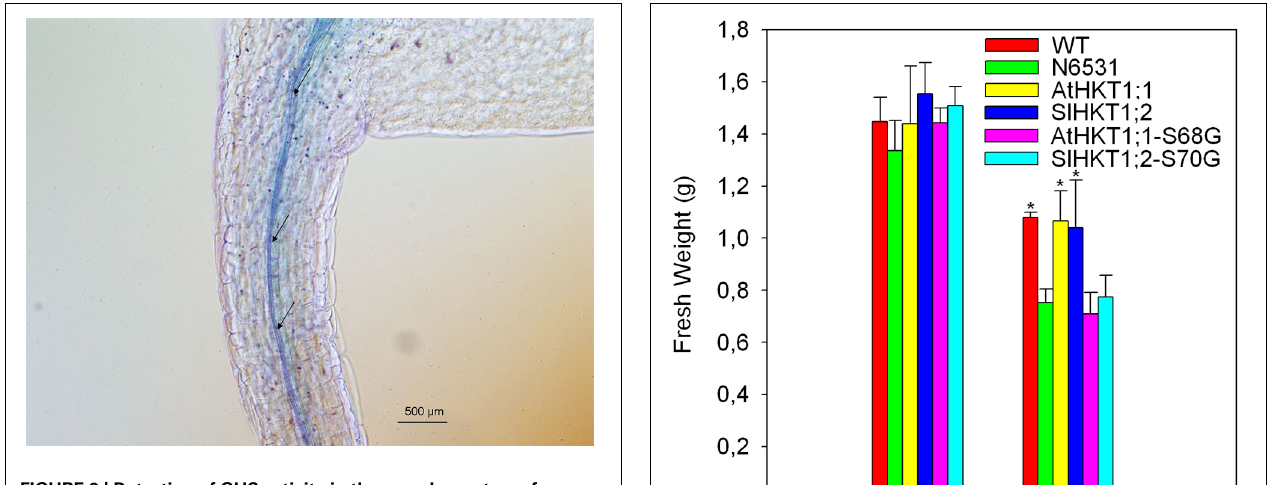
FIGURE 3 | Detection of GUS activity in the vascular system of transgenic Arabidopsis thaliana plants. Arabidopsis plants expressed the GUS gene under the control of the AtHKT1;1 promoter were grown. Strong blue GUS staining was detected in the vicinity of the xylem and phloem in leaves. Arrows point to the xylem vessels. Biological replicates, n = 3; plantlets, n = 7.